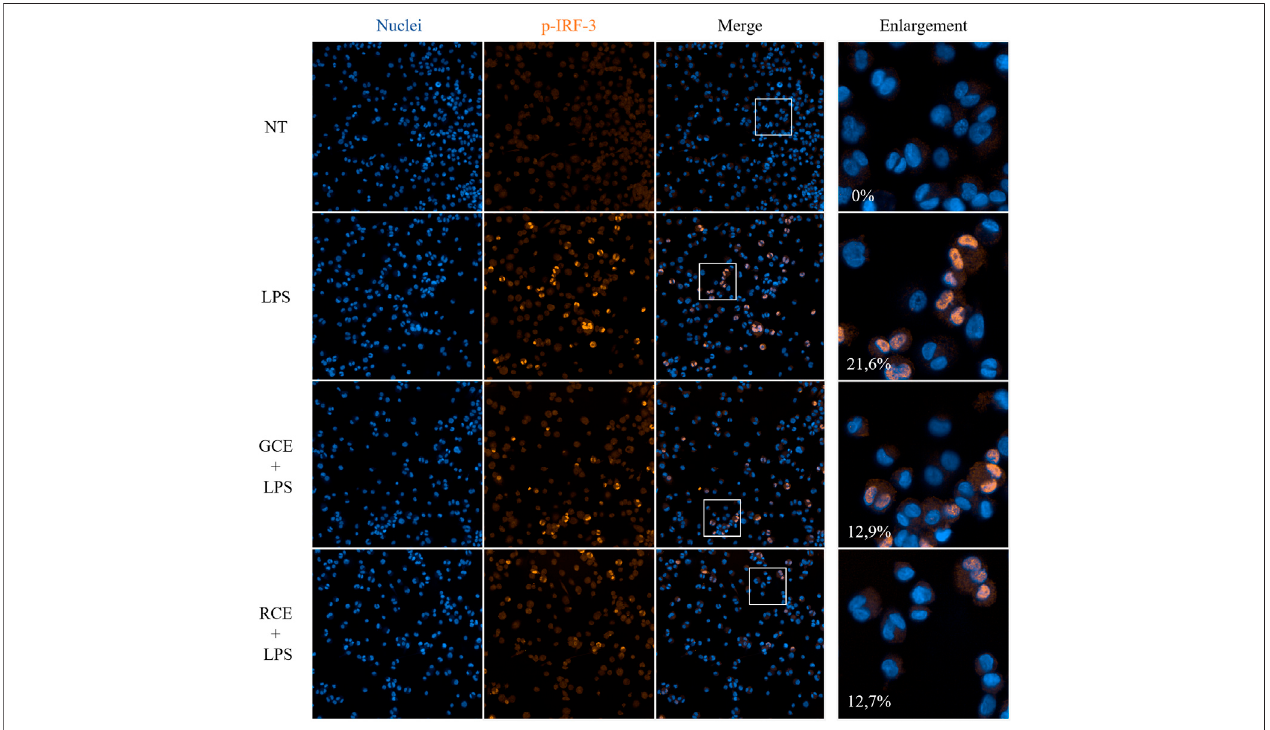
FIGURE 6 | Immuno fl uorescence analysis of p-IRF-3 nuclear translocation. Phospho-IRF-3 localization in THP-1-derived macrophages (TDM) after 250 μ g/ml GCE or RCE pre-treatment (1 h) and LPS stimulation (2 h). Images have been acquired using the Operetta CLS ™ High-Content Analysis System and analyzed through Harmony 4.5 software with the following settings: original magni fi cation ×20, water objective, confocal mode. Pictures are representative. Data represents the percentage of positive nuclei (nuclear fl uorescence above a certain threshold) and are expressed as mean of different fi elds of view acquired ( n = 9).